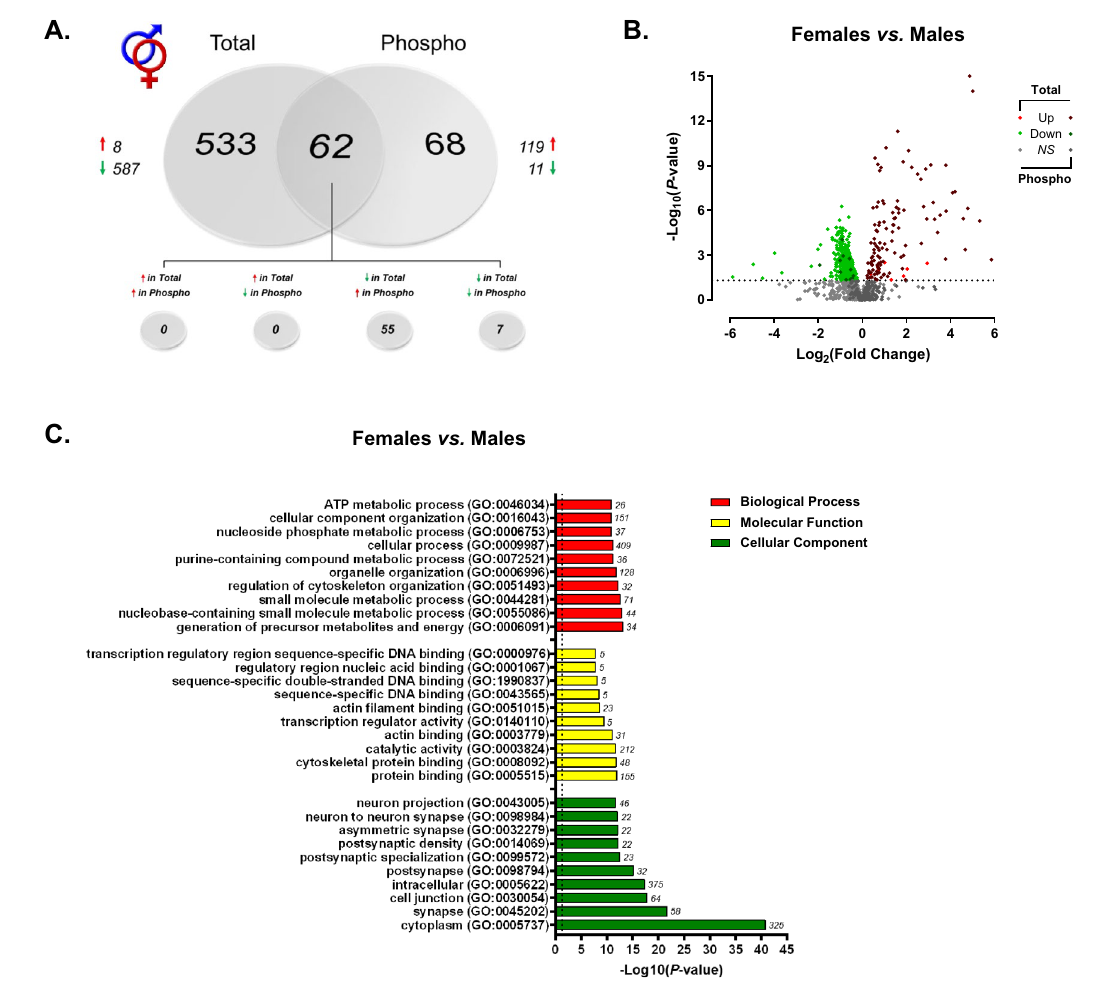
Figure 2. Sex-dependent total and phosphoprotein expression in the dHPC. ( A ) Venn diagram showing significantly lower total protein abundance, but greater phosphoprotein abundance in the dHPC of female vs. male rats. Each circle represents the significant female vs. male differences in abundance of proteins (“Total”) or phosphoproteins (“Phospho”), with the overlap representing proteins whose levels differed in both fractions. ( B ) Volcano plot depicting significant differences in protein and phosphoprotein abundance between female and male rats. Log 2 (Fold Change) values > 0 (red) indicate higher, and those < 0 (green) lower, abundance in females compared to males. Dots above the horizontal dashed line represent proteins with p < 0.05 (FDR threshold set at 1%). ( C ) Top 10 most significant ( p < 0.05) gene ontology (GO) enrichment terms per category of proteins and phosphoproteins with significant sex-dependent abundance